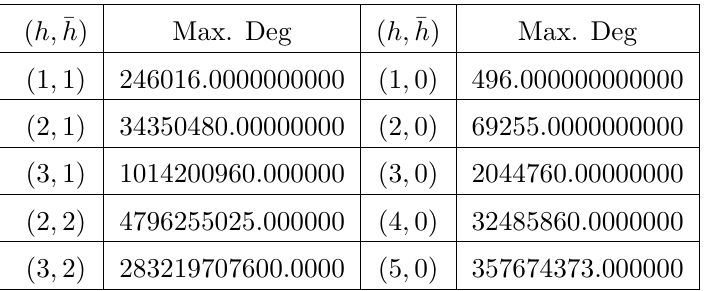
Table 9. The maximum value of degeneracies for low-lying states in a putative CFT with c = 16. Here the maximum number of derivative is set to N max = 55, while the spin was truncated at j max = 40.